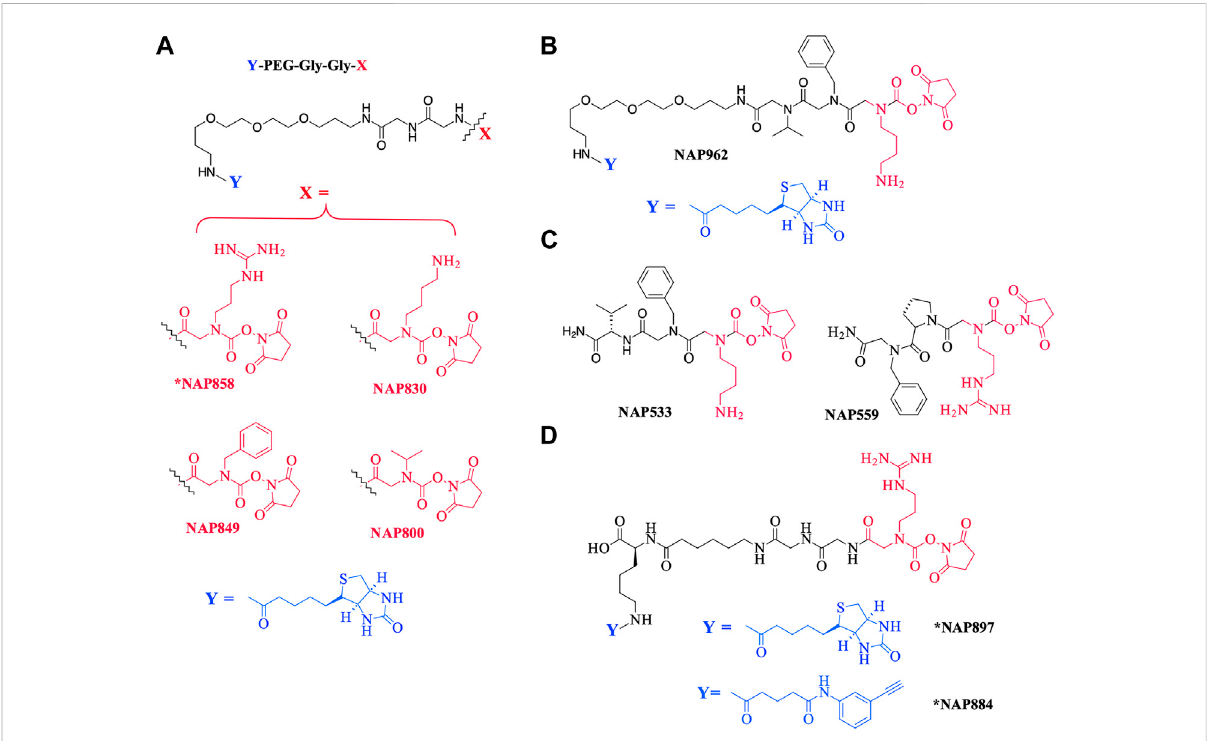
FIGURE 2 Chemical structures of N-alkyl glycine N-Hydroxy succinimidyl carbamates. (A) *NAP858, NAP830, NAP849, and NAP800. (B) NAP962. (C) NAP533, and NAP559. (D) *NAP884 and *NAP897. Structures marked with * are taken from Ferguson et al. (2022), all others are from the present